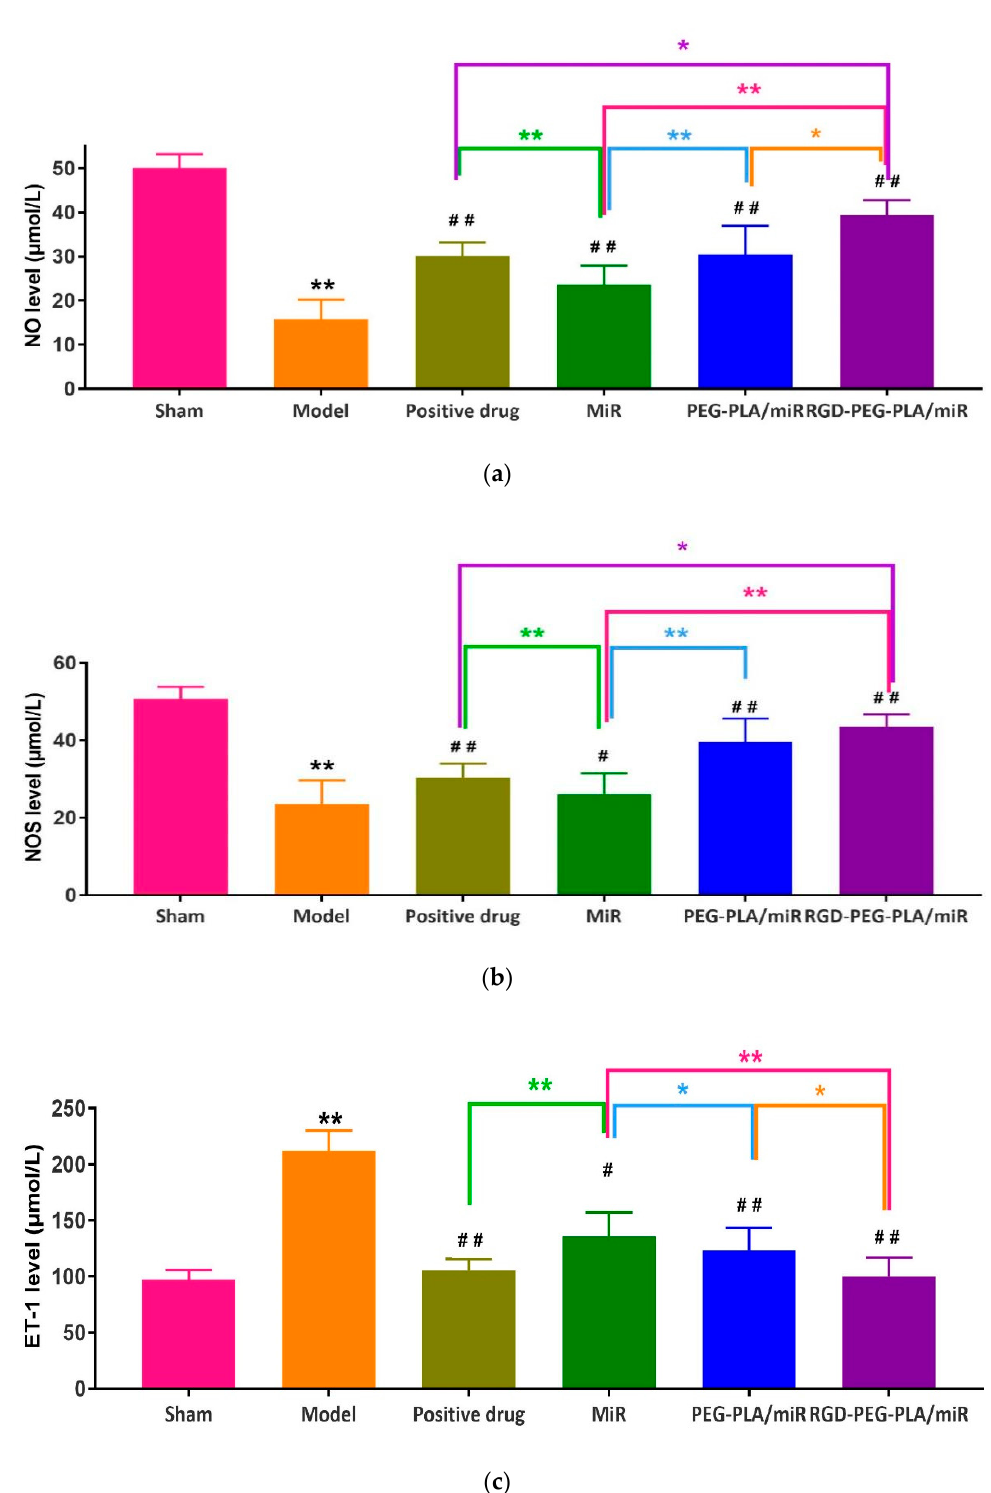
Figure 10. The levels of ( a ) nitric oxide (NO), ( b ) nitric oxide synthase (NOS), and ( c ) endothelin-1 (ET-1) in six groups of rats (mean ± SD, n = 6). Compared with the sham group, the difference was statistically significant (** p < 0.01). Compared with the model group, the difference was statistically significant ( # p < 0.05, ## p < 0.01). The color asterisks indicate significant differences between the two groups, ** p < 0.01.